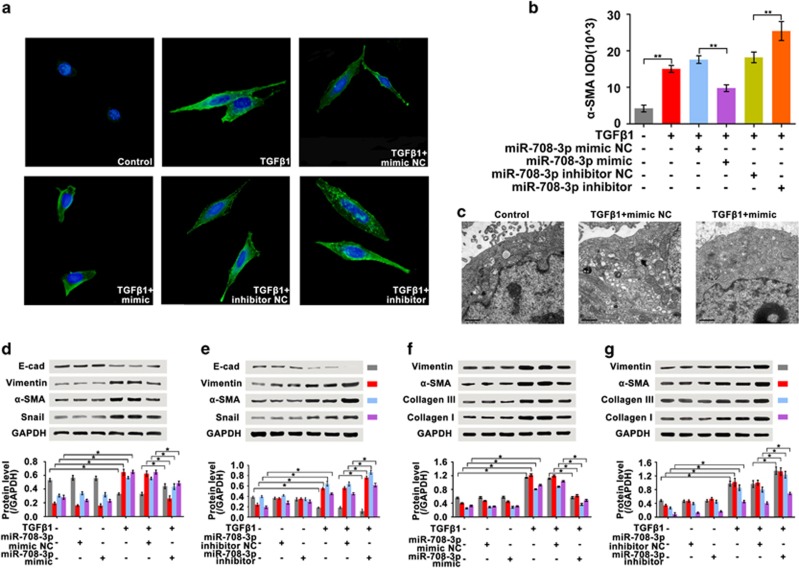
In vitro effect of miR-708-3p in IPF. A549 and MRC-5 cells were first transfected with miR-708-3p mimic or inhibitor for 6 h and then co-treated with TGF-β1 for 72 h. (a, b) Immunofluorescence analysis showed that the miR-708-3p mimic improved A549 cell shape and reduced α-SMA expression, but the miR-708-3p inhibitor induced the opposite results. (c) The miR-708-3p mimic improved the A549 ultrastructural changes, as observed by TEM. (d) The miR-708-3p mimic markedly promoted E-cadherin expression and diminished α-SMA, vimentin and Snail in A549 cells. (e) The miR-708-3p inhibitor markedly reduced E-cadherin and promoted α-SMA, vimentin and Snail expression in A549 cells. (f) The miR-708-3p mimic markedly decreased vimentin, α-SMA and collagen I and III expression in MRC-5 cells. (g) The miR-708-3p inhibitor markedly promoted vimentin, α-SMA and collagen I and III expression in MRC-5 cells. Each bar represents the mean±s.d.; n=6, *P<0.05, **P<0.01. TEM, transmission electron microscopy.